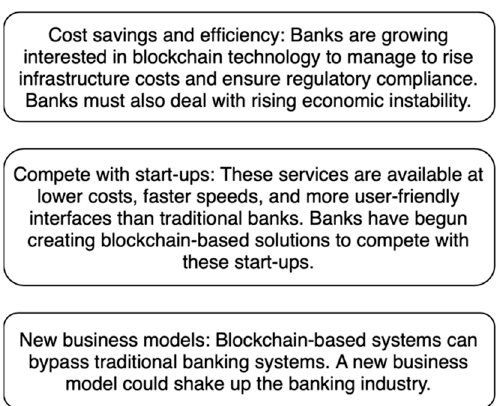
Figure 9. Main reasons for financial firms to invest in